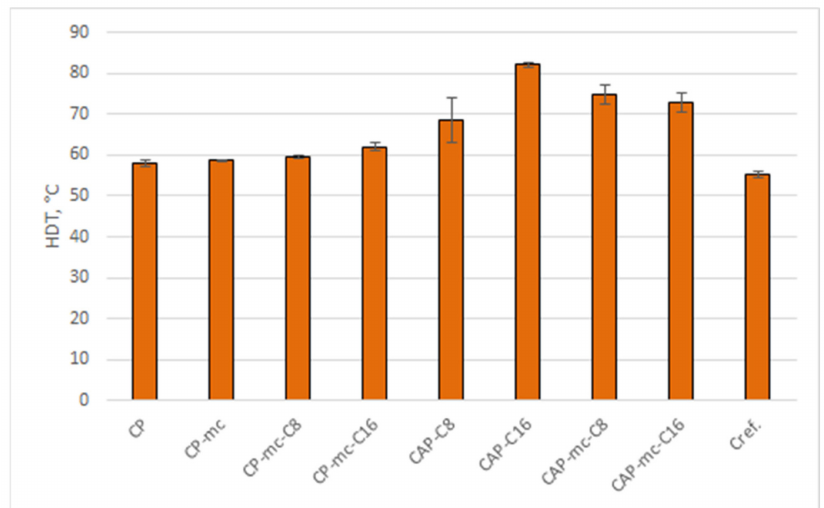
Figure 6. Heat distortion temperatures for injection molded materials. CP is commercial cellulose acetate propionate with 13% commercial plasticizer, CP-mc is 20% microcellulose containing CP, CP-mc-C8 contains also 4% cellulose octanoate C8, CP-mc-C16 contains 4% of cellulose palmitate C16, CAP-C8 contains neat cellulose acetate propionate (CAP) with 17% C8, CAP-C16 contain 17% C16 in CAP, CAP-mc-C8 contains 20% mc and 17% C8 in CAP, CAP-mc-C16 contains 20% mc and 17% C16 in CAP and Cref is PLA-based material with 20% cellulose fibre.